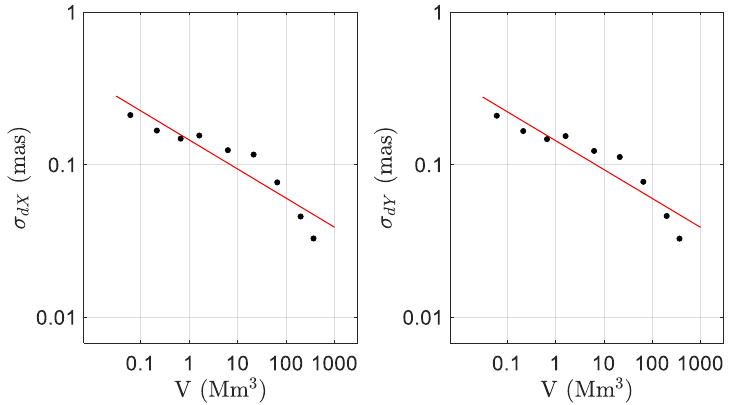
by [14] for a shorter period of analysis and it also showed a clear relationship between CPO cision and network volume. precision and network volume.